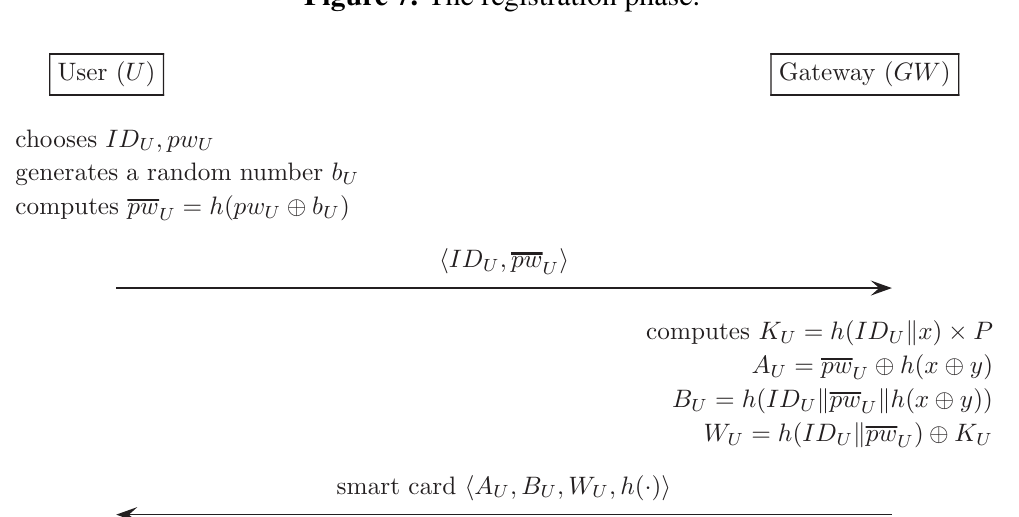
Figure 7. The registration